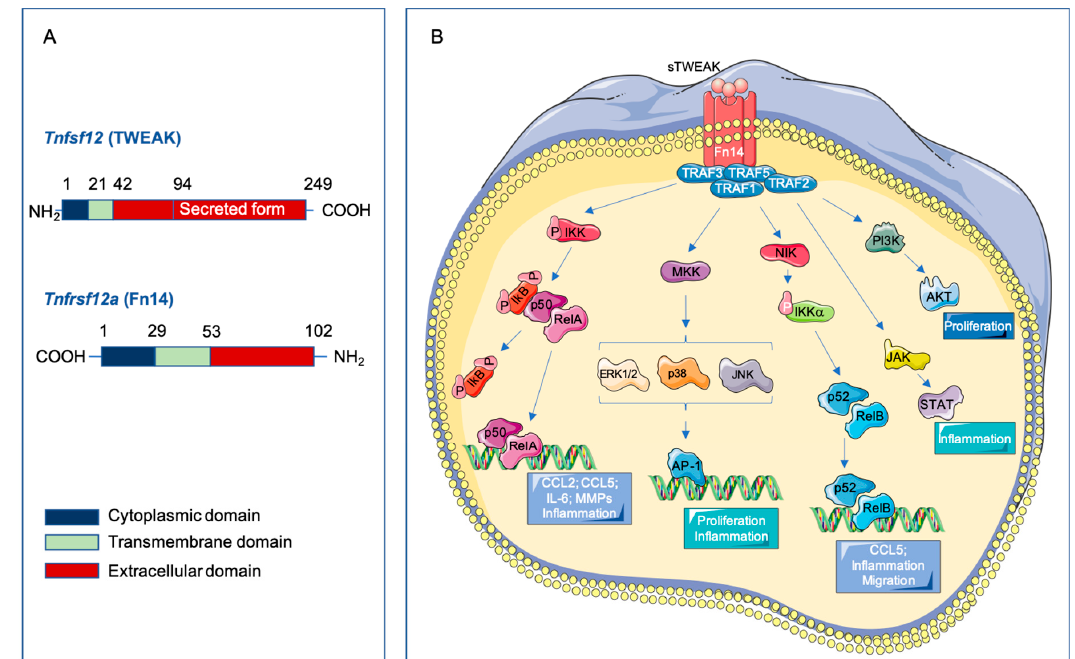
Figure 1. Tumor necrosis factor-like weak inducer of apoptosis (TWEAK)/ fibroblast growth factor-inducible 14 (Fn14) Signaling. ( A ) Schematic representation of human TWEAK and Fn14 receptor structure showing full-lengths and TWEAK secreted form. ( B ) Soluble TWEAK binds to the extracellular domain of the Fn14 receptor and produces its trimerization. This structural change of the receptor triggers the recruitment of TRAF proteins to its cytoplasmic tail and the activation of the different pathways; canonical (p50/RelA) and non-canonical (p52/RelB) NF-kB, ERK/JNK/p38 and AP-1, JAK/STAT and PI3K/AKT. Increased activation of these signaling pathways leads to the regulation of specific target genes with their biological mechanistic